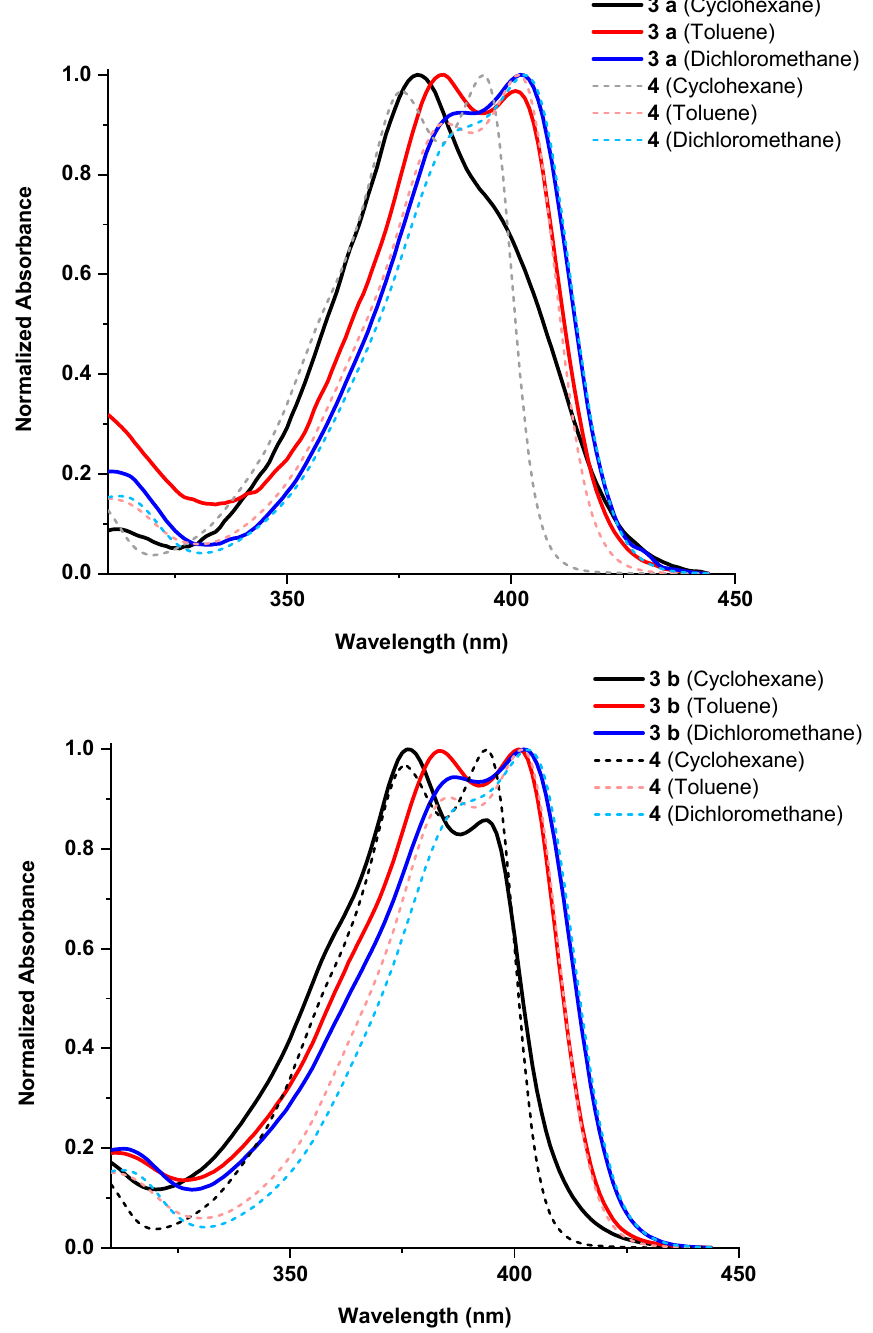
Figure 22. Normalized UV-visible absorption spectra of polymers 3 a,b in various solvents (RT, OD < 1). On the contrary, in cyclohexane, the absorption spectrum of 4 is slightly hypsochromi- cally shifted with peaks at approximately 394 nm (maximum), 376 nm and 355 nm